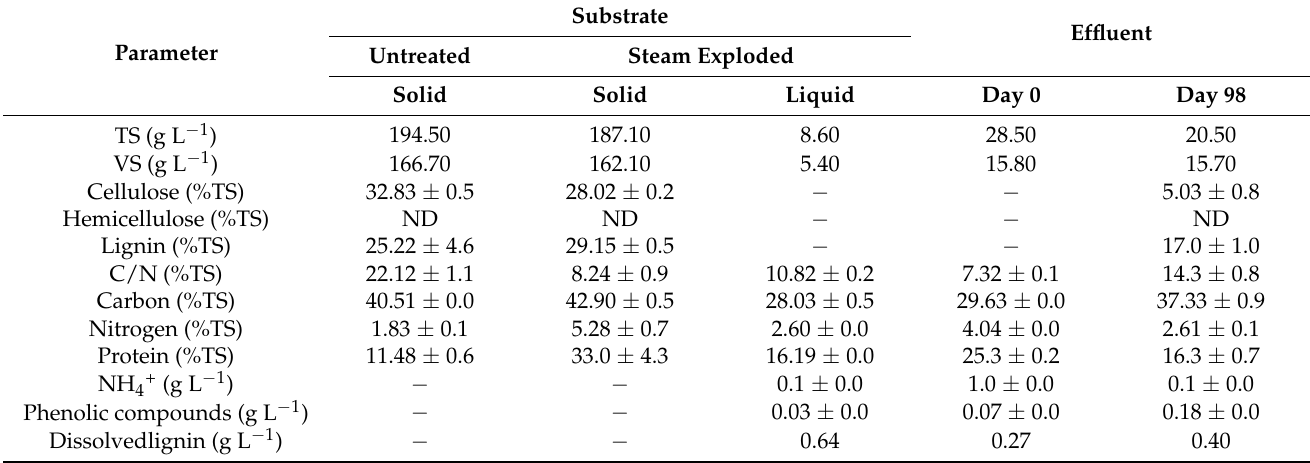
Table 2. Chemical composition of the untreated and pretreated substrate and effluent.